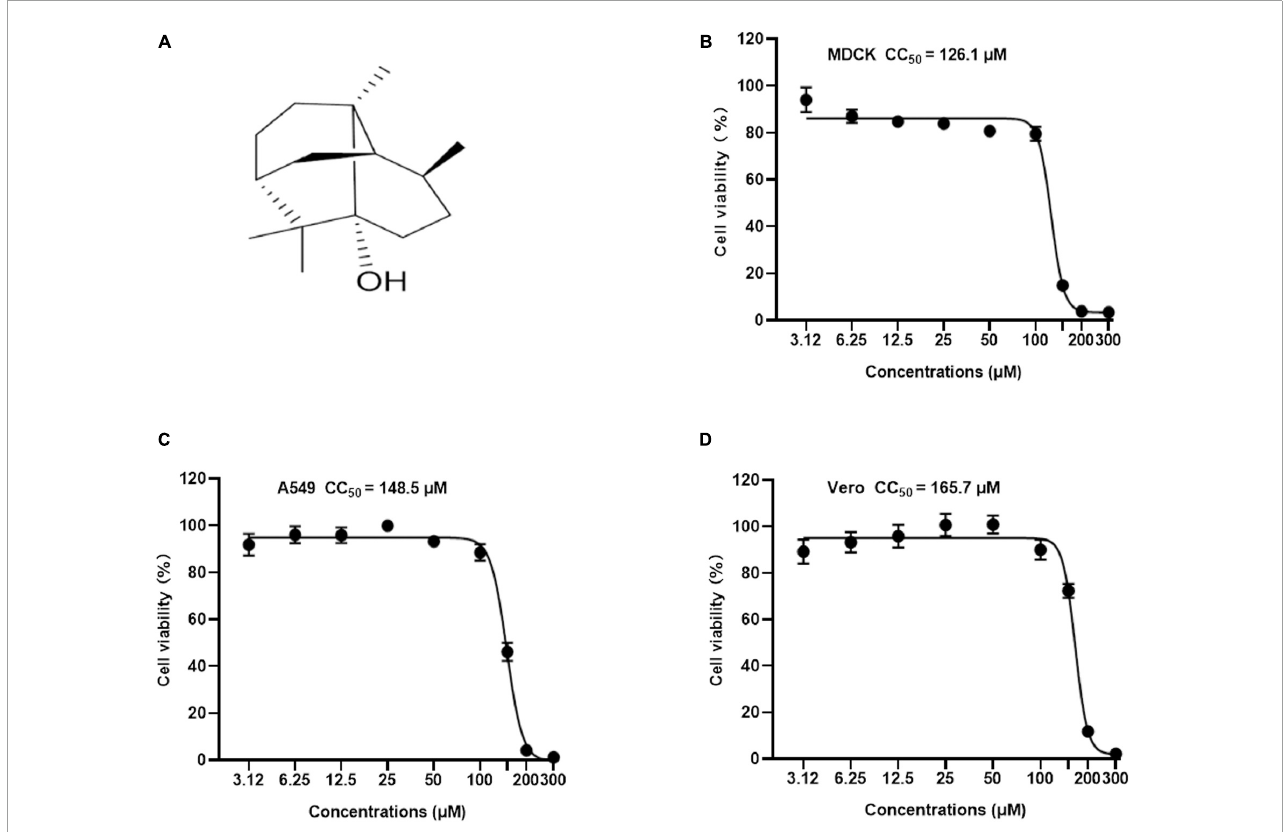
FIGURE1 The chemical structure and cytotoxicity of Patchouli alcohol were evaluated by cell viability assay. (A) Chemical structure of Patchouli alcohol. (B) The CC 50 of Patchouli alcohol was determined by cell viability assay in MDCK cells. (C) The CC 50 of Patchouli alcohol was determined by cell viability assay in A549 cells. (D) The CC 50 of Patchouli alcohol was determined by cell viability assay in Vero cells. n = 3, each concentration conducted in